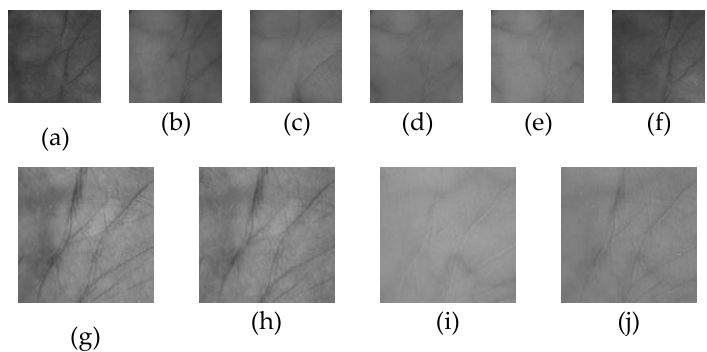
Figure 4. Some typical multispectral palmprint images in the PolyU database and CASIA database. ( a )~( f ) Samples under the 460 nm, 630 nm, 700 nm, 850 nm, 940 nm, and white spectrums in the CASIA database, ( g )~( j ) Samples under the Blue, Green, NIR, and Red spectrums in the PolyU database.